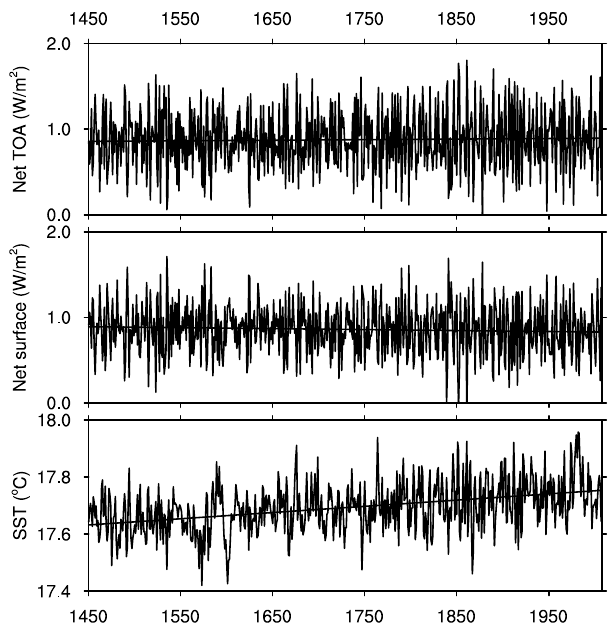
Figure 1. The global mean TOA and surface net radiation flux, global mean SST over the piControl simulation period. The black lines are linear